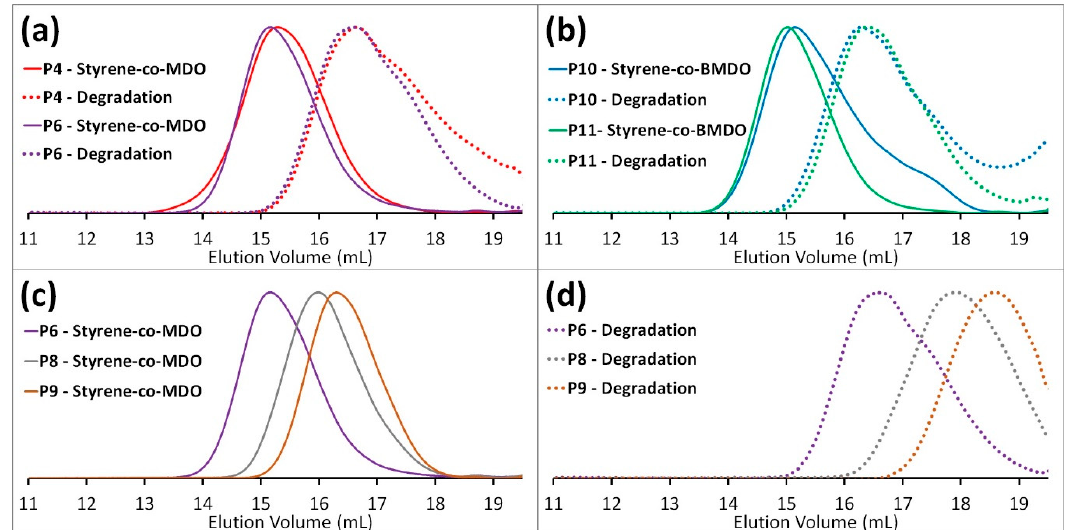
Figure 5. SEC traces of selected degradable poly(CKA- co -styrene) copolymers and of their Figure5. SECtracesofselecteddegradablepoly(CKA- co -styrene)copolymersandoftheircorresponding corresponding oligomeric degradation products obtained via ester bond cleavage, (a) polymers P4 - oligomeric degradation products obtained via ester bond cleavage, ( a ) polymers P4 - P6 original and P6 original and degradation SEC traces, (b) polymers P10 and P11 original and degradation SEC degradation SEC traces, ( b ) polymers P10 and P11 original and degradation SEC traces, ( c ) P6 , P8 and traces, (c) P6 , P8 and P9 original polymer SEC traces, (d) P6 , P8 and P9 degradation SEC traces. P9 original polymer SEC traces, ( d ) P6 , P8 and P9 degradation SEC